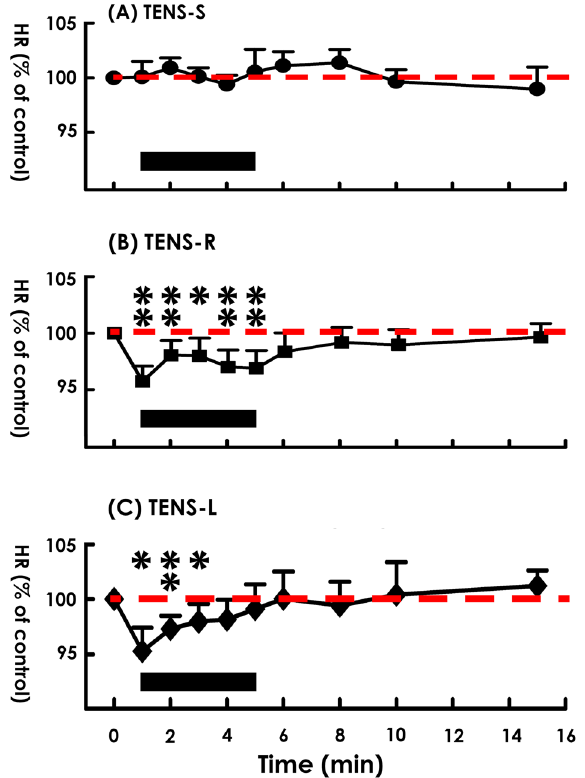
Figure 3. Mean heart rate (HR) of subjects in response to ( A ) sham stimulation (TENS-S) and ( B , C ) TENS on the right and left shoulder (TENS-R and TENS-L, respectively). The black bar at the bottom indicates the stimulation period. DF = 2, F = 5.31; p < 0.01 among groups; DF = 9, F = 1.94; p < 0.05 among time points; Two- way ANOVA. * p < 0.05; ** p < 0.01 versus baseline control; post hoc.